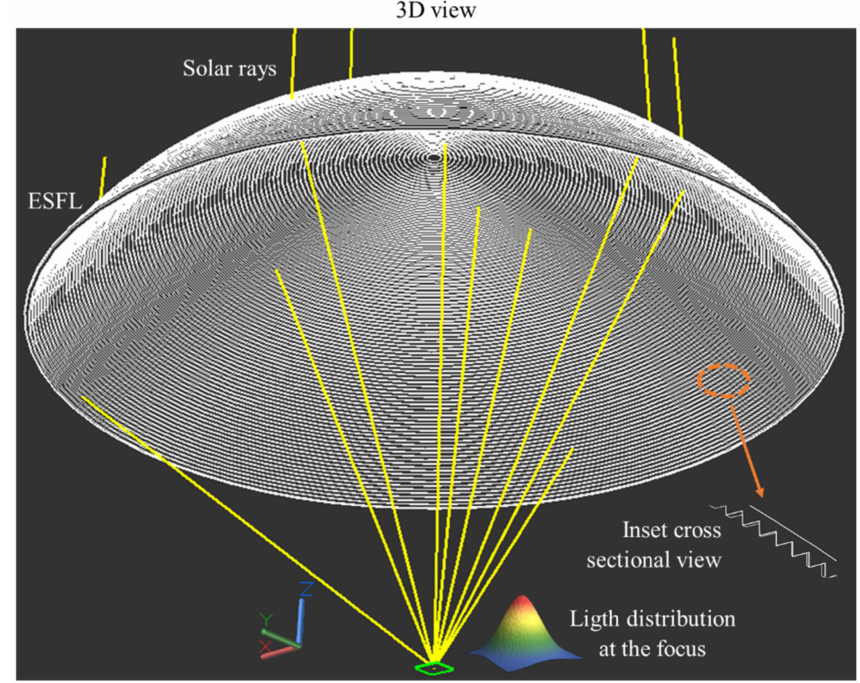
Figure 7. 3D view of the ESFL in AutoCAD.